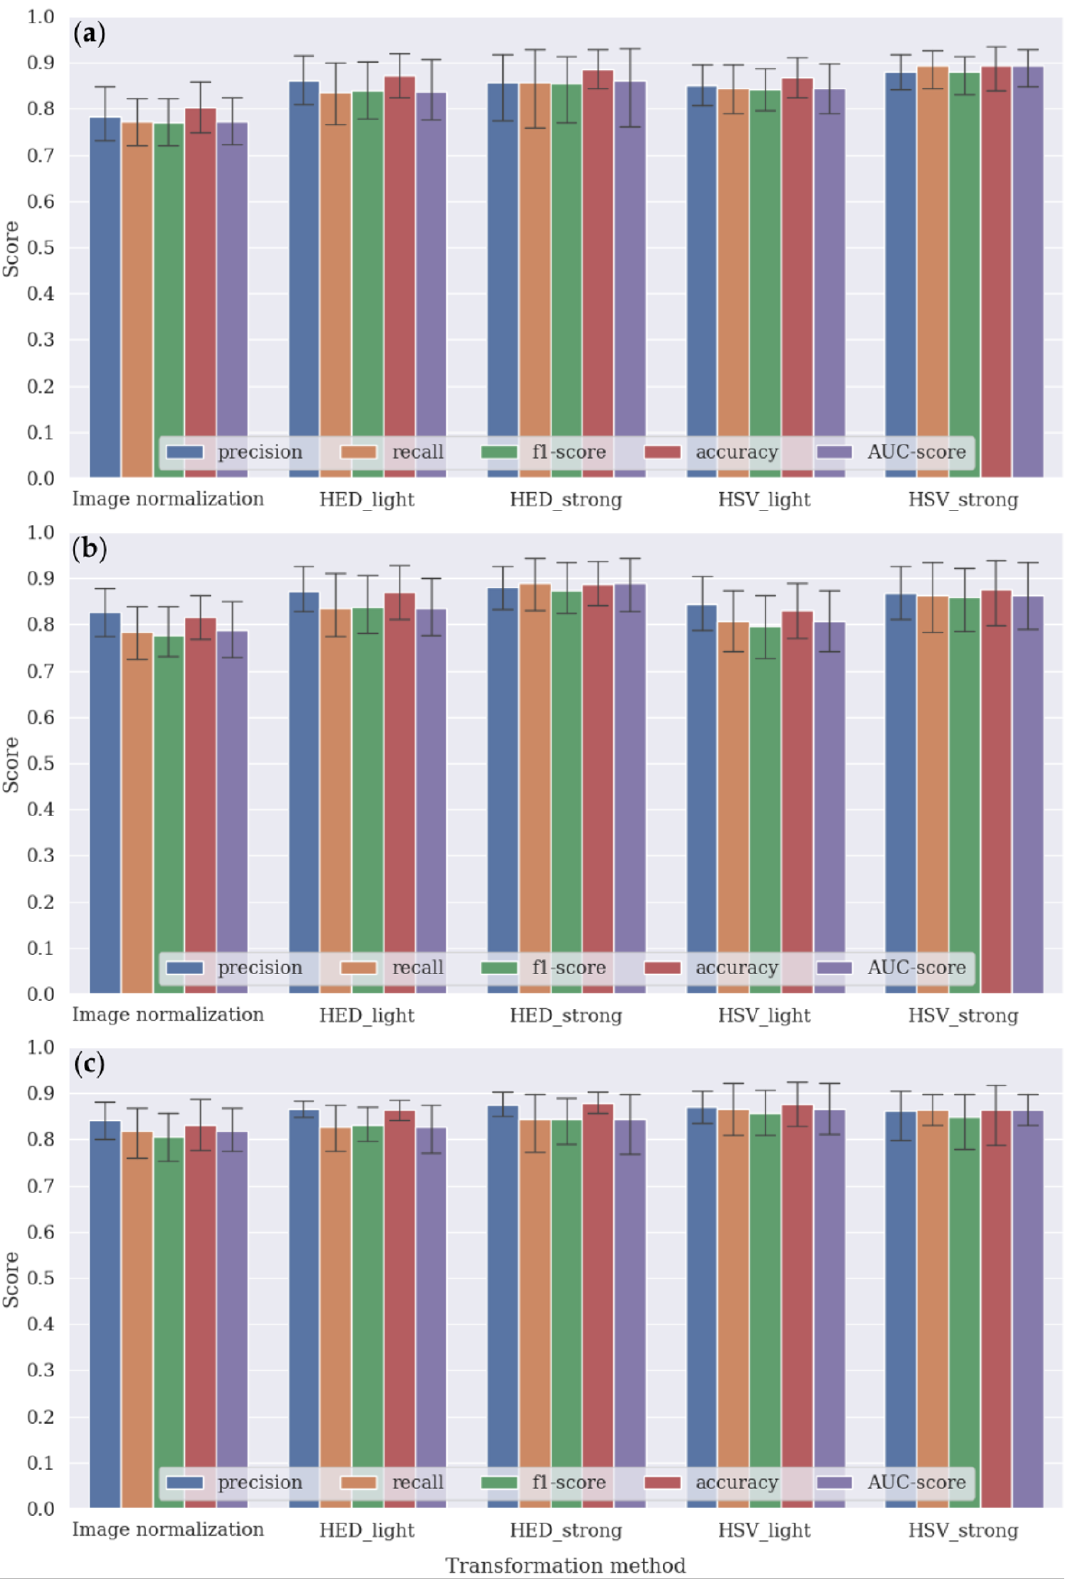
Figure 7. Tumor classification results obtained via five different transformation methods using the ( a ) DenseNet161, ( b ) VGG16, and ( c ) EfficientNet_b4 CNN models.